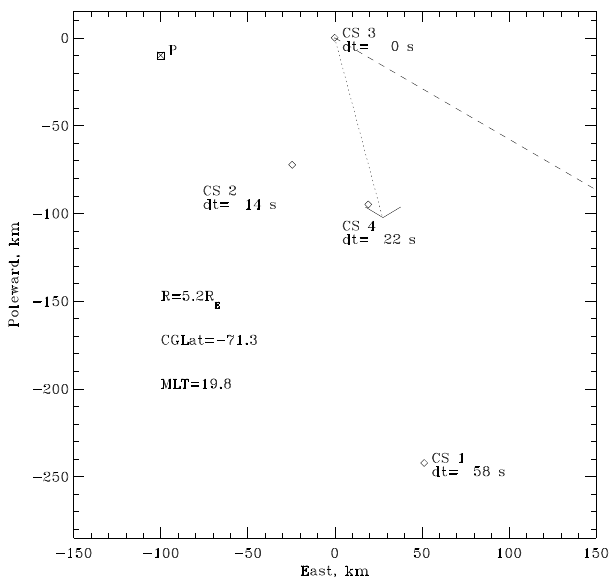
Fig. 6. 27 April, 2002. The direction of motion (dotted line) and configuration of the s/c in a plane perpendicular to the background magnetic field. dt is the time separation of the satellites passing through this plane, with respect to s/c 3. The orientation of the current sheet (see the text) is shown as a dashed line.